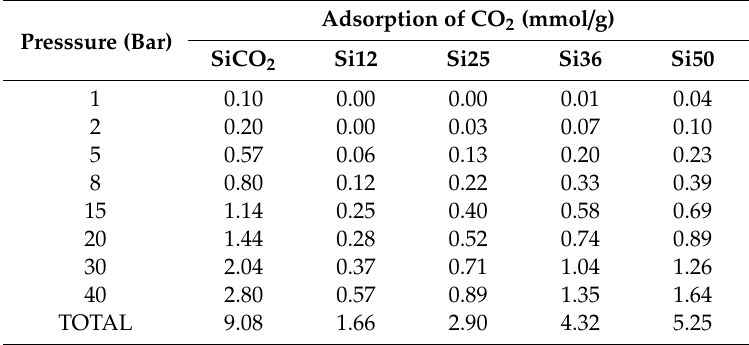
Table 2. CO 2 adsorption capacities obtained at di ff erent pressures.